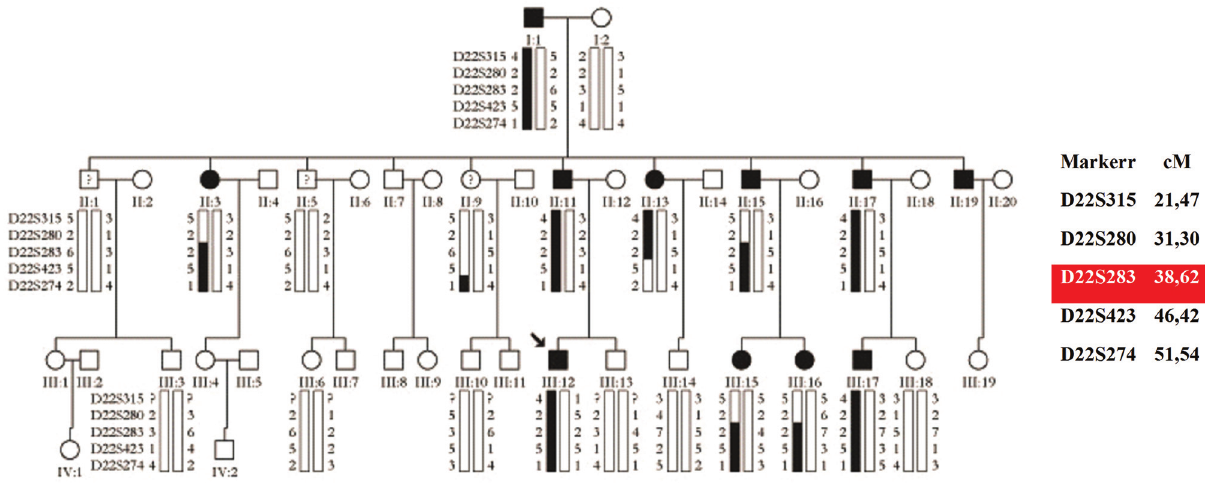
Figure5 -Haplotypesegregationofmicrosatellitedataforchromosome22.Theprobandisindicatedbyanarrow.Individualswith?areaffectedbyhear- ing loss only in high frequencies, with age of onset at 40 years. The mapped locus based on haplotype segregation is represented in